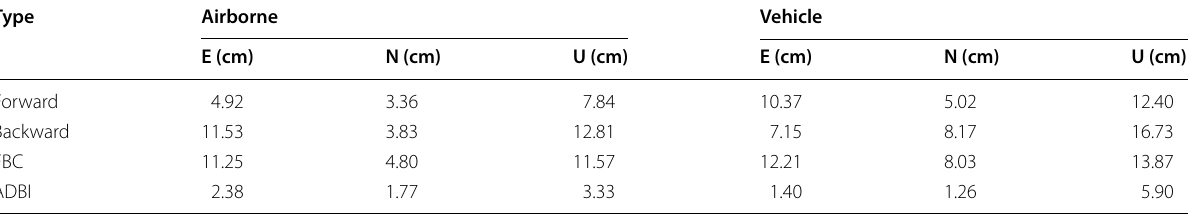
Table 2 RMS of position errors for different processing mode with airborne data and vehicular data